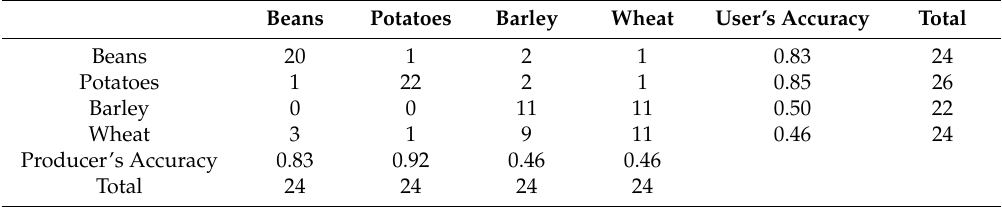
Table 1. Confusion matrix for neural network model trained to discriminate four crop types.